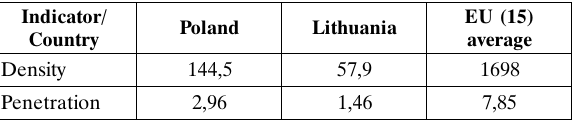
Table 8. Structure of premiums (life and non-life) in UE 15,